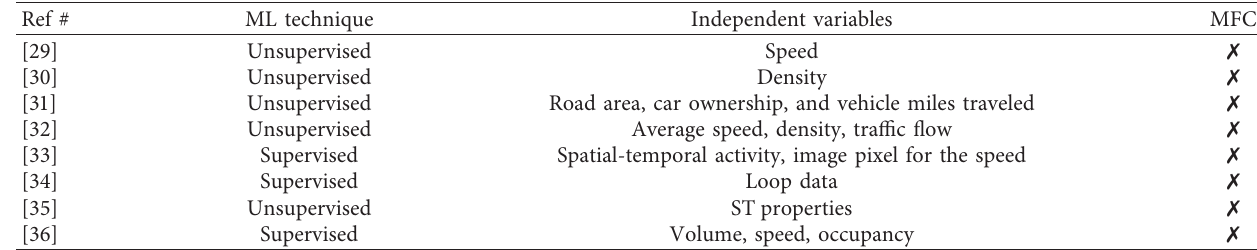
Table 2: Summary of congestion detection